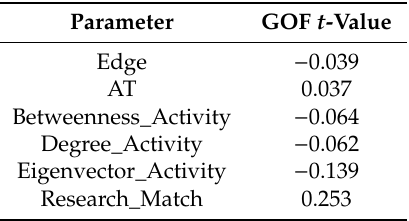
Table 3. The goodness of fit (GOF)